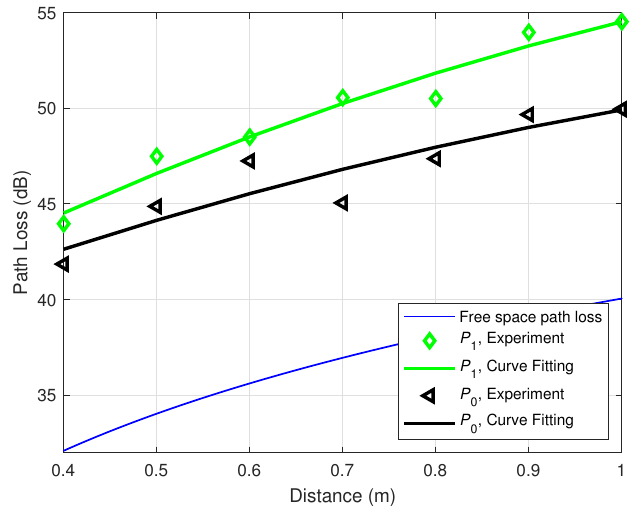
Figure 7. Off-body path loss for different power levels at data rate 9600